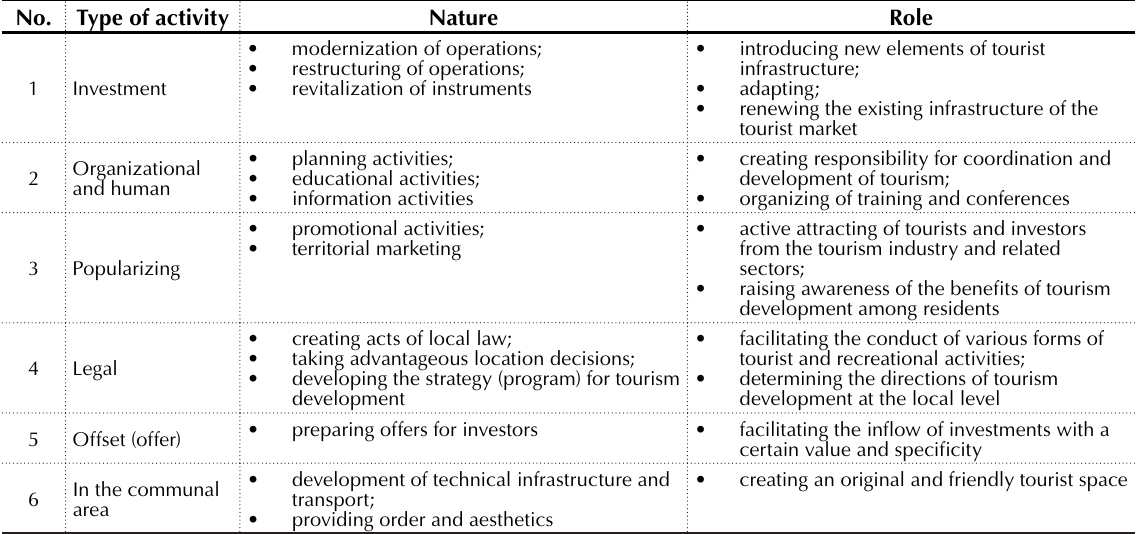
Source: developed by the authors based on Zalech